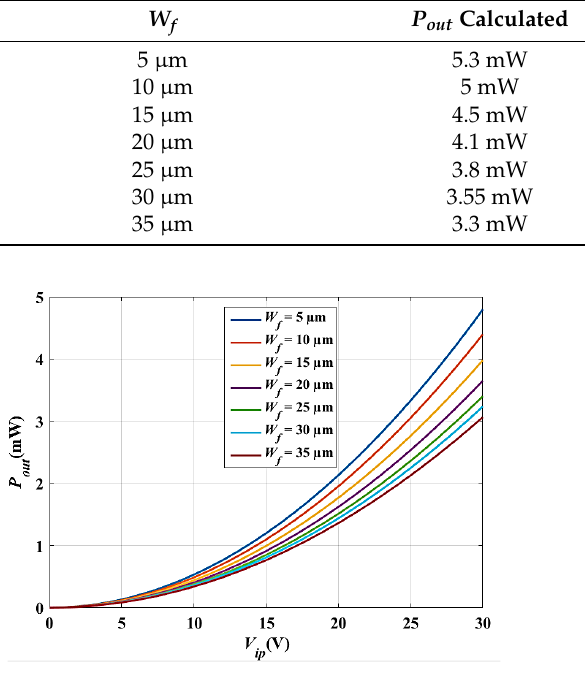
Figure 10. P out versus V ip at different W f .